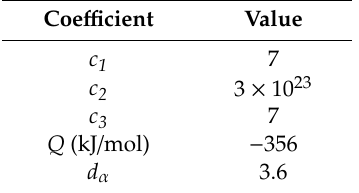
Table 5. Coe ffi cient used in Equation (10) for grain growth during static recrystallization [27]. Coe ffi